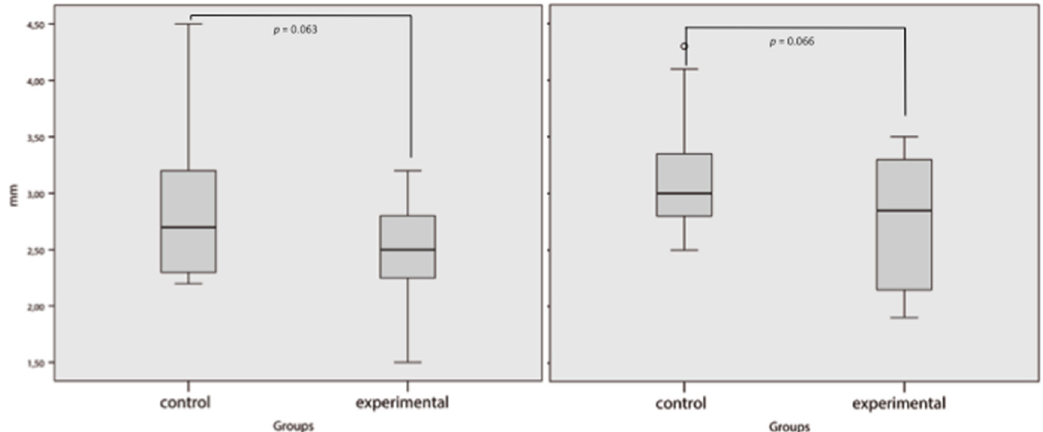
Figure 3. Sub-metatarsal skin thickness. Left figure for first metatarsal head and right figure for second metatarsal head. p value < 0.05 was considered significant.